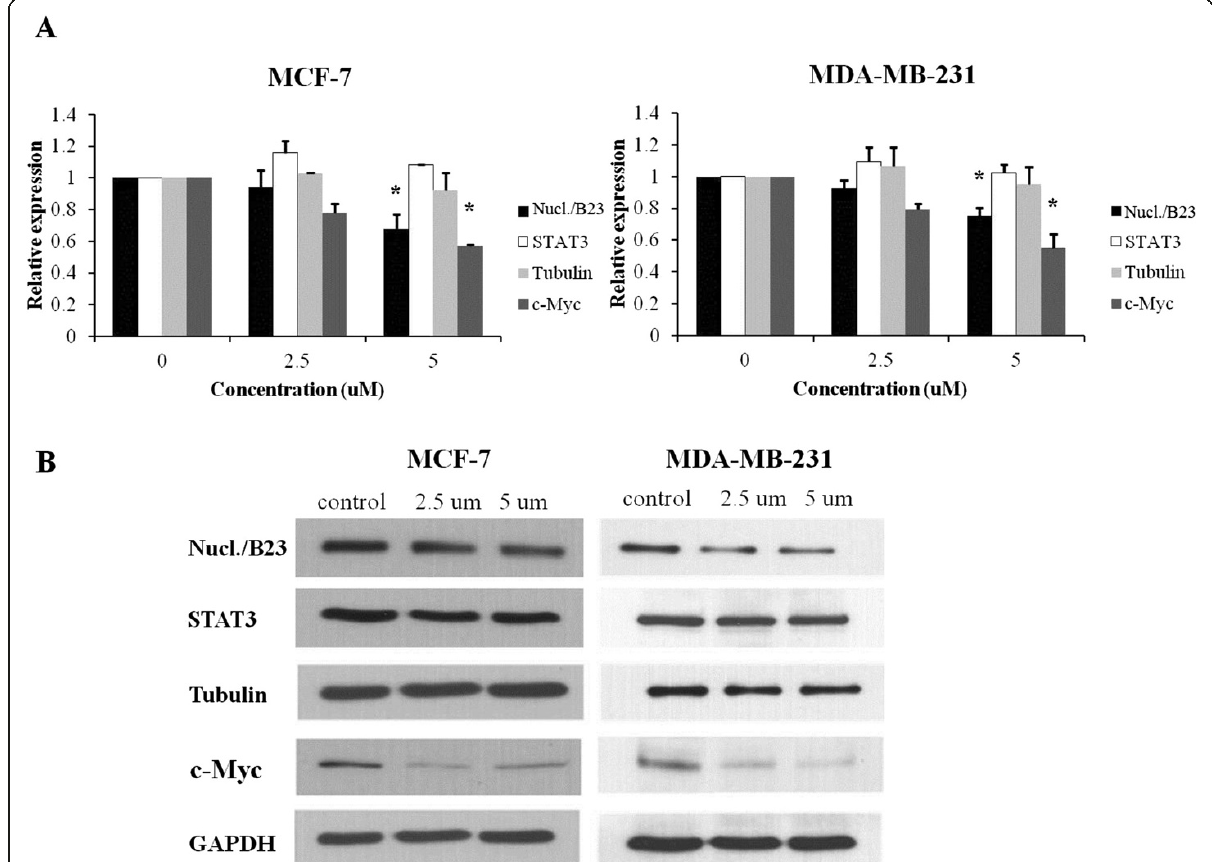
Figure 5 Effect of cucurbitacin B on the level of nucleophosmin/B23, STAT3, tubulin, and c-Myc expression. MCF-7 and MDA-MB-231 were treated with 0, 2.5, and 5 μ M cucurbitacin B for 48 hr. A . RNA was extracted for real-time RT-PCR to quantitate the gene expression levels of nucleophosmin/B23, STAT3, tubulin, and c-Myc after cucurbitacin B treatment. Results shown are the average of three independent experiments. *, P < 0.05 (treated vs untreated control) B . Western blot was analyzed for protein expression. GAPDH was used as loading